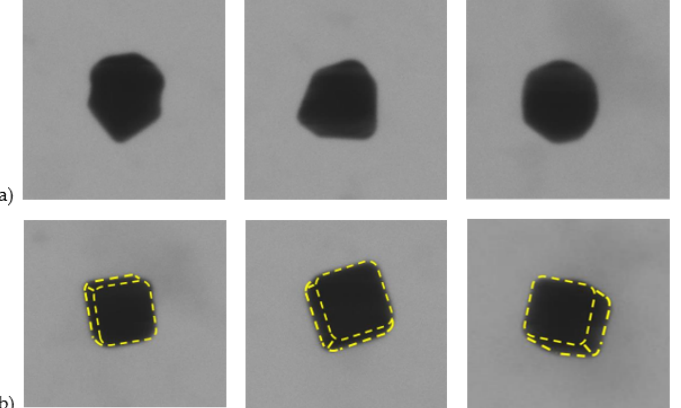
Figure 12. Examples of ( a ) non-cubic particles or ( b ) inclined nanocubes (side not parallel with the substrate).